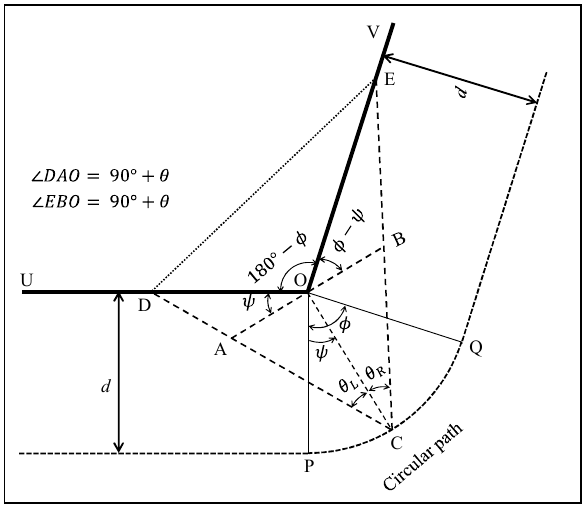
Figure 2. Image footprints of convergent image acquired on a circular path Internal angle   180   is complementary angle of the exterior angle. Circular curve between points P and Q, marked at a distance d, indicates locus of camera positions for acquisition of convergent images at a constant distance from the corner O. Point C is the camera position on the circular path and angle ψ represents the camera position in left half of the circular path. Similarly, the line OQ is a reference line for measuring a camera position in right half of the circular path. Field of view (FOV) of a camera is generally divided in two equal parts are considering  and  for left and right parts of the FOV L R around the optical axis (as shown in figures in this